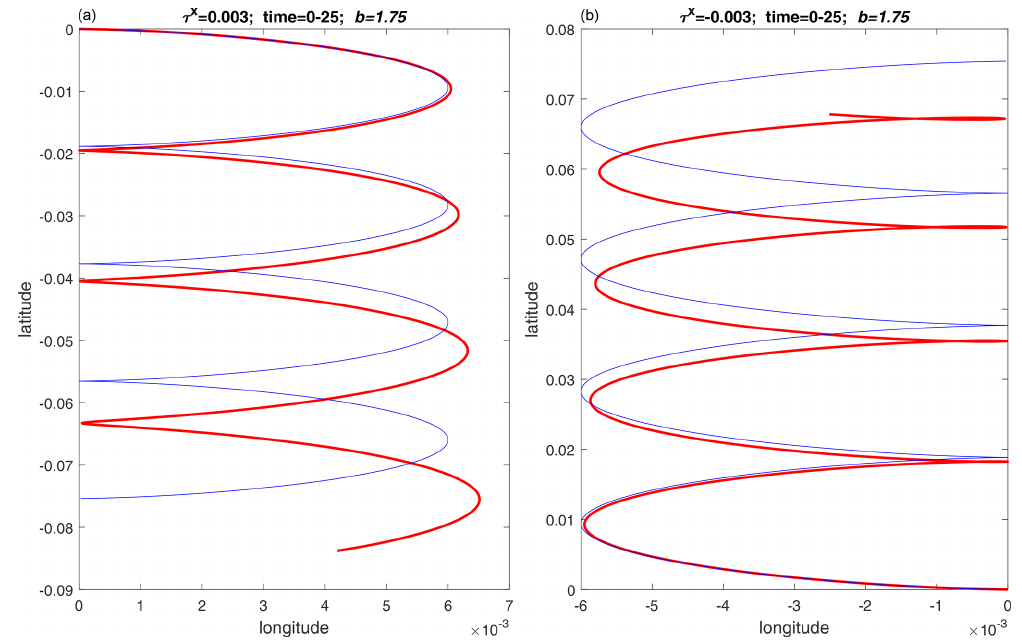
Figure 1. The (longitude, latitude) trajectories of water columns at the ocean surface subject to westward-directed (b) and eastward- directed (a) wind stress on the f plane (blue curves) and on the β plane (red curves). The time unit is the inverse of the mean Coriolis frequency, and the longitude and latitude distances are scaled on Earth’s radius. The value of b (scaled β ) corresponds to 30 ◦ latitude. The scaling of the wind stress ( τ x ) is detailed in Sect. 2. Both trajectories start from (x,y) = ( 0 , 0 ) located at the bottom right point in the right panel and at the upper left point in the left